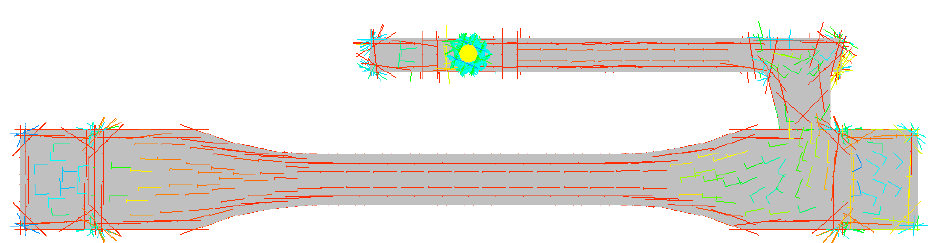
Figure 6. Overmolding product.